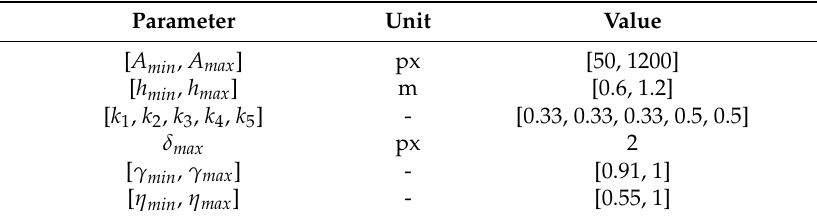
Table 3. Image processing algorithm parameters used during the